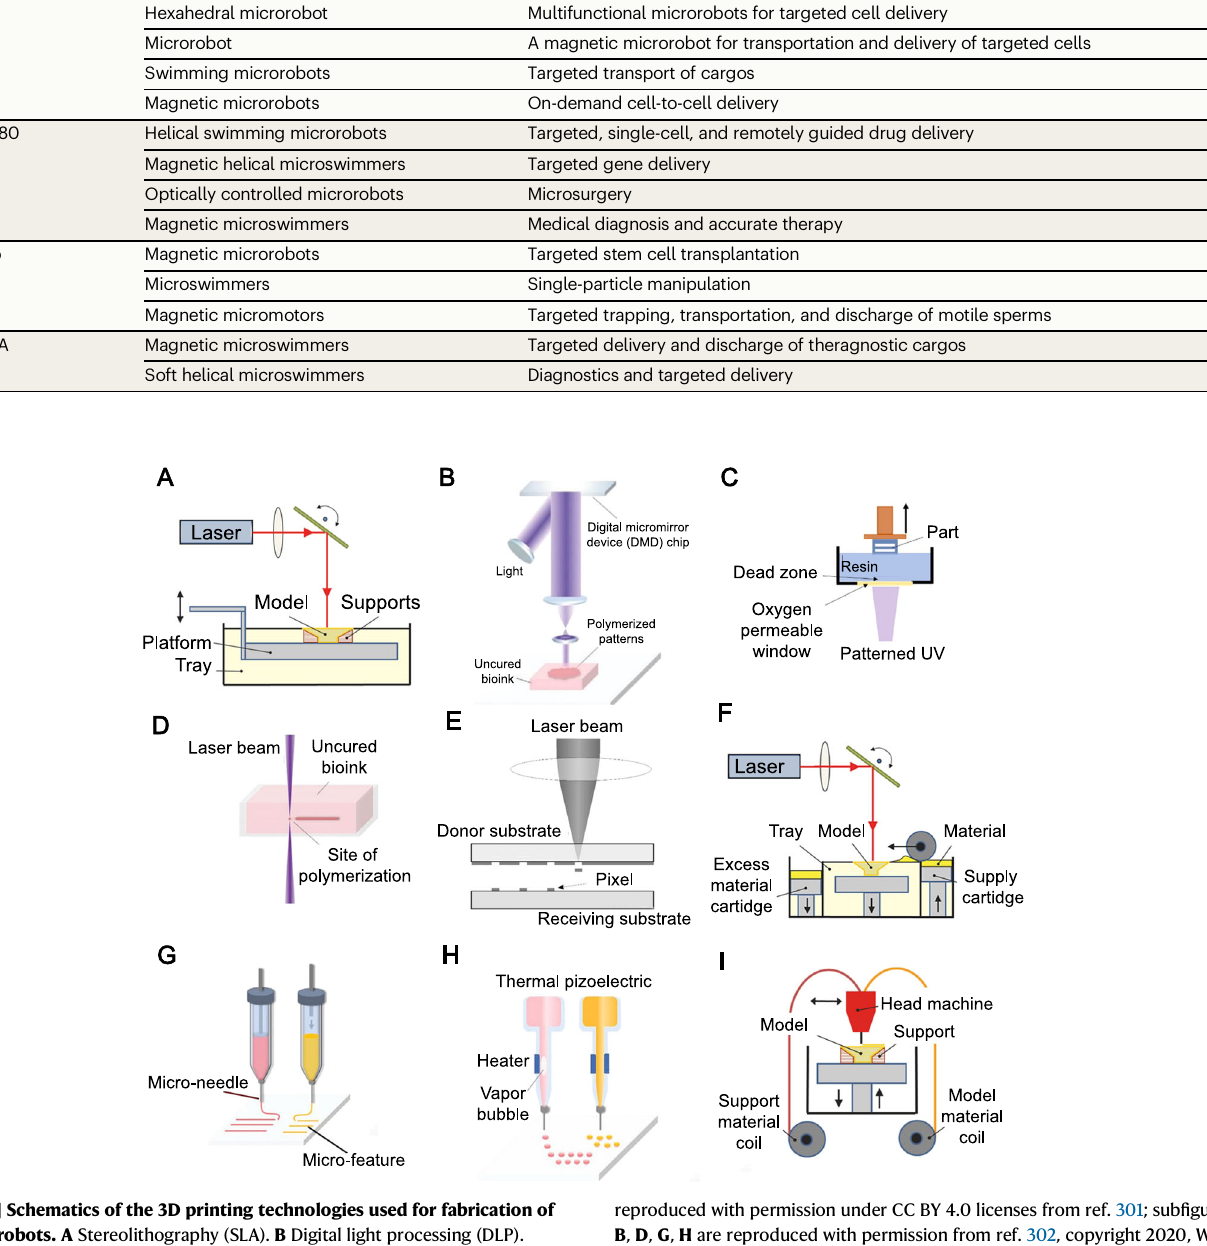
Table 1 | Structures and applications of materials used in the fabrication of microrobots Material